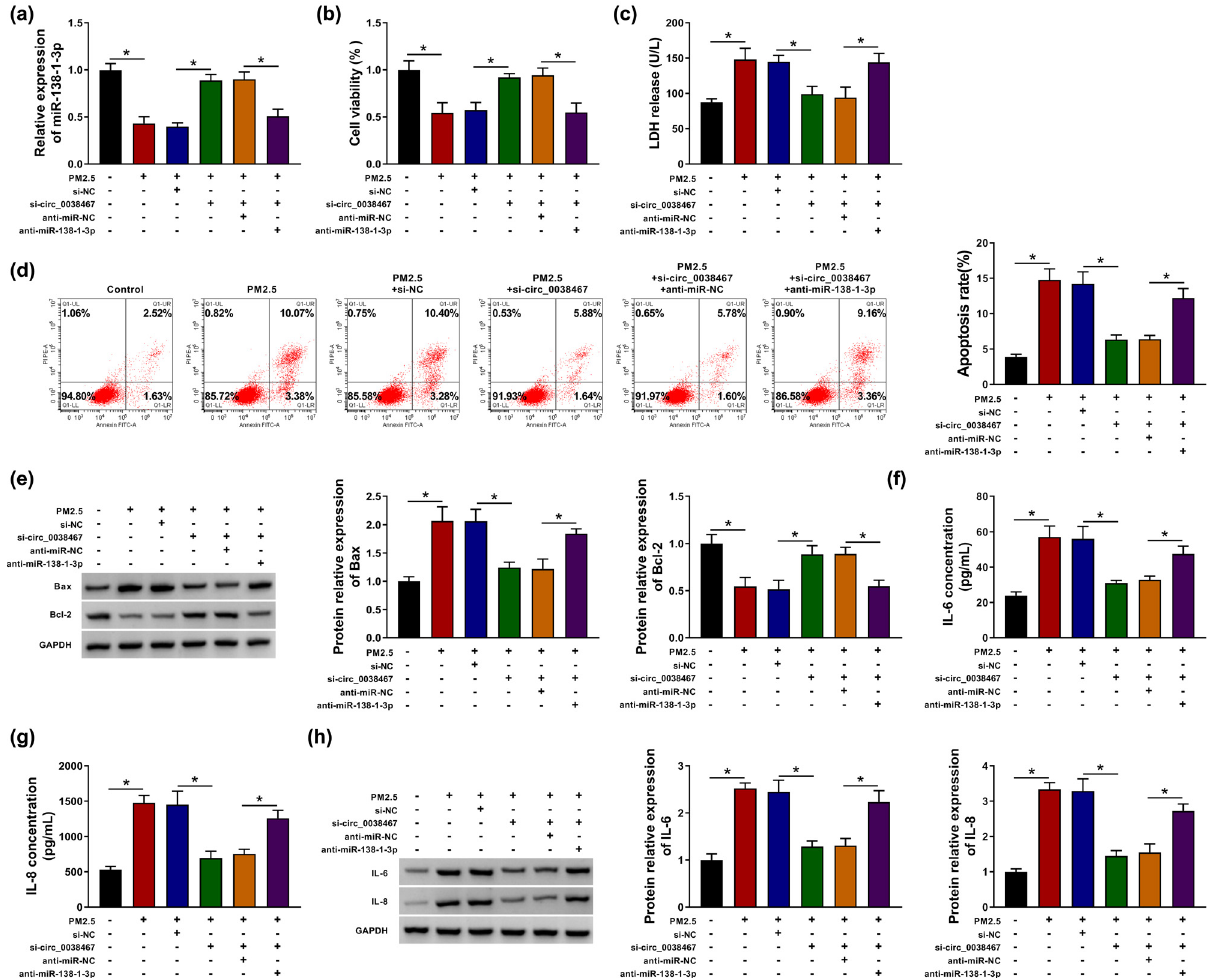
Figure 5: circ_0038467 knockdown reduced PM2.5 - induced cell death and in fl ammatory response in BEAS - 2B cells via miR - 138 - 1 - 3p. BEAS - 2B cells were stably transfected with si - NC, si - circ_0038467, si - circ_0038467 + anti - miR - NC, or si - circ_0038467 + anti - miR - 138 - 1 - 3p, and then treated with 75 μ g/mL PM2.5 for 48 h. ( a ) RT - qPCR analysis of miR - 138 - 1 - 3p expression in BEAS - 2B cells. ( b ) BEAS - 2B cell